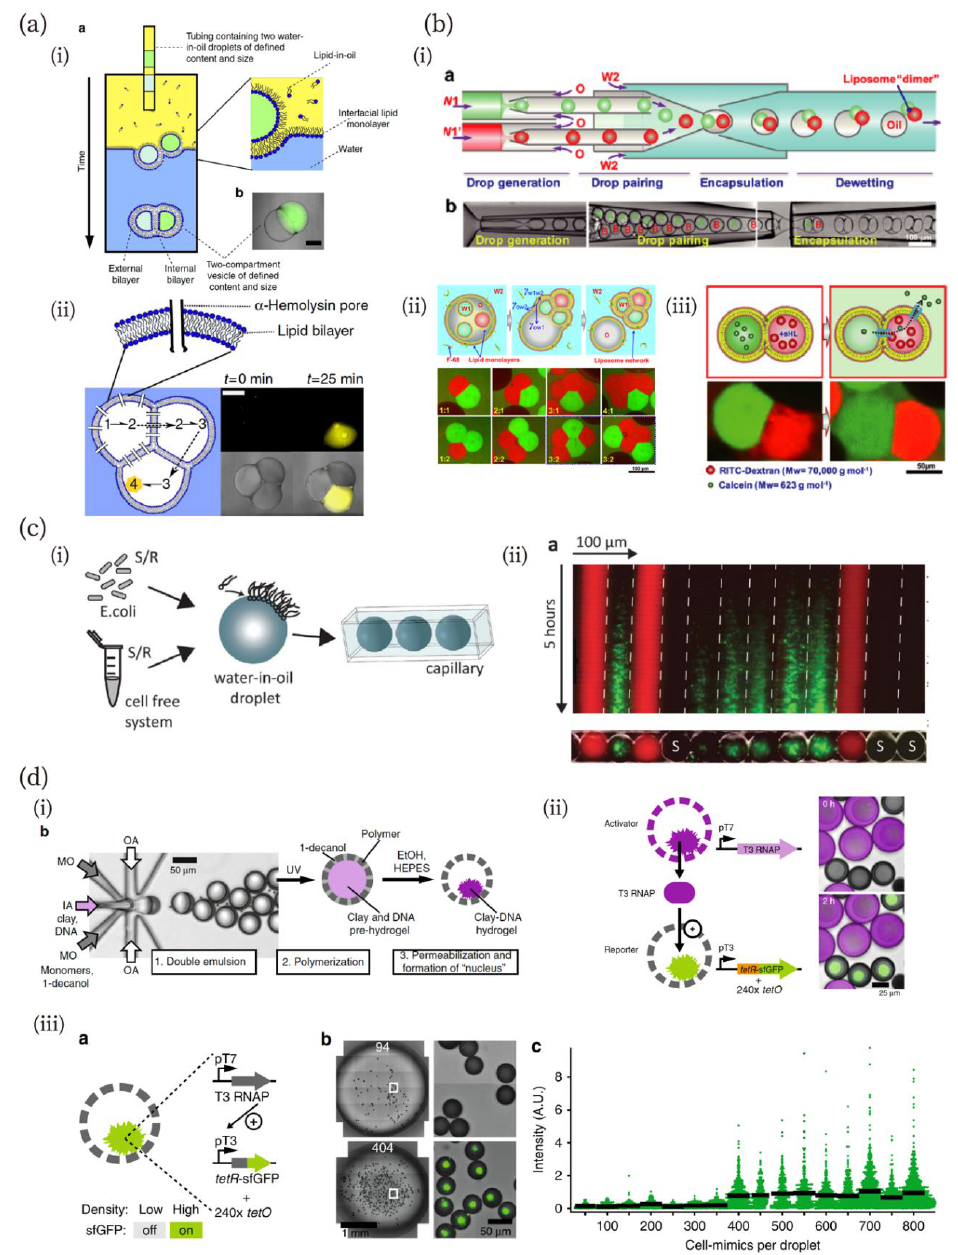
Figure 3. ( a ) Multi-compartment formation via the phase transfer of multiple droplets and